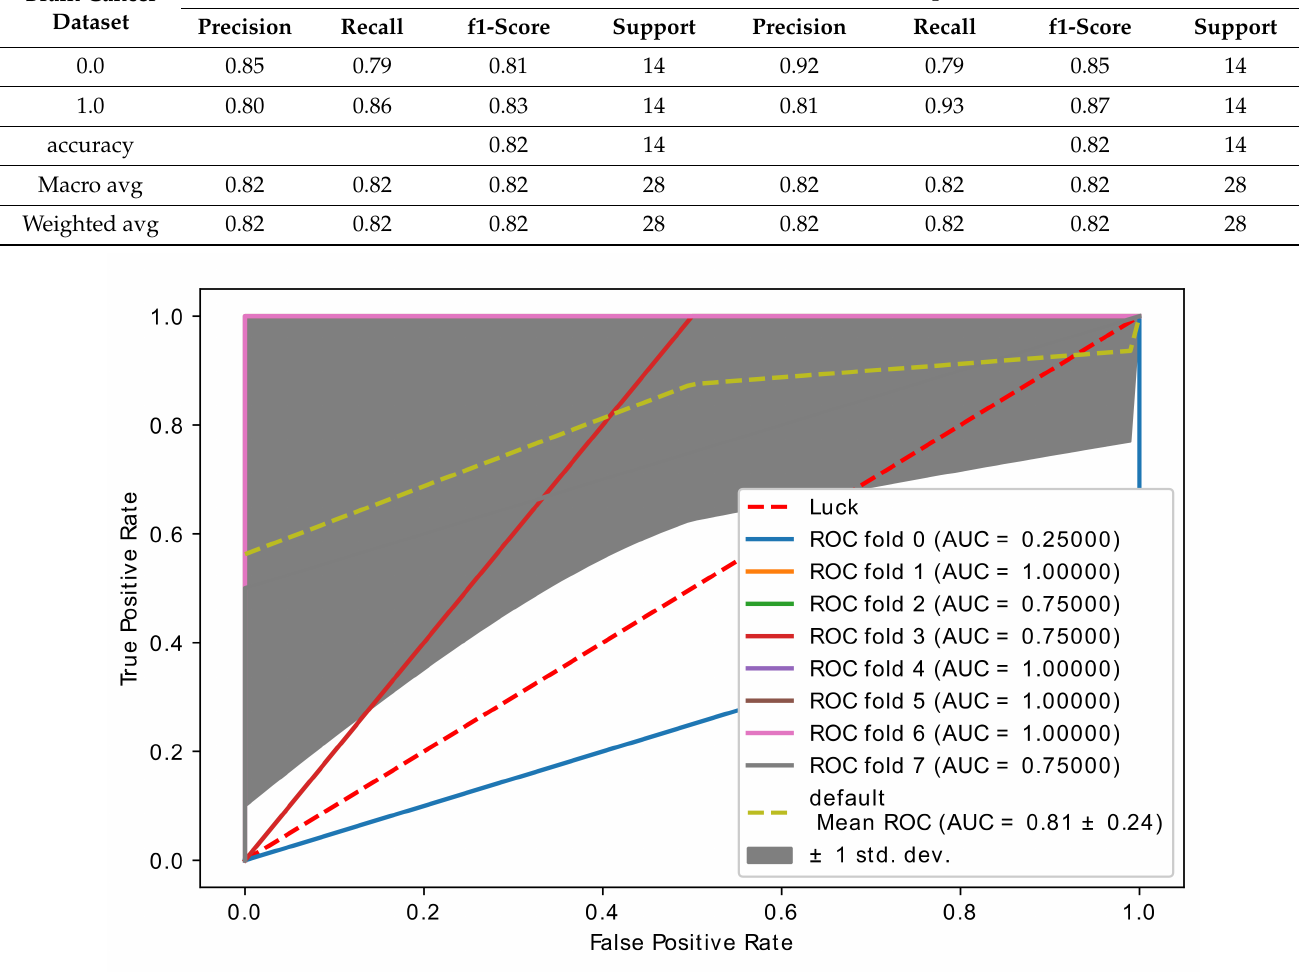
Figure 6. Accuracy curve obtained using the hybrid model with CatBoost